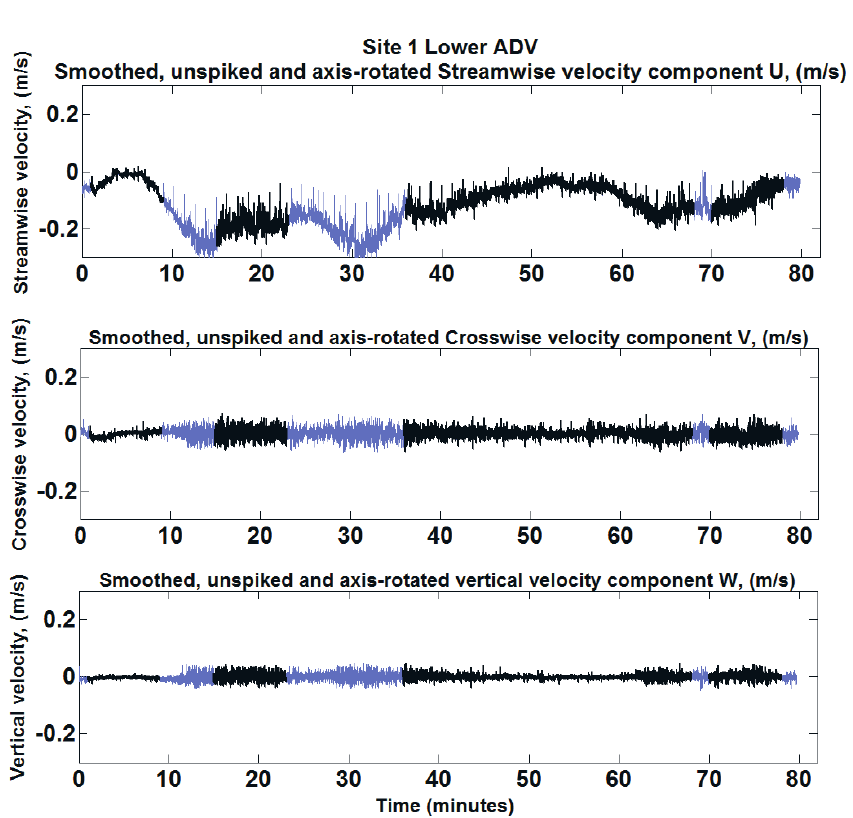
Figure 7. Eight minute sections selected in black for the lower ADV of site 1 (0.32 m above seabed). For each section the mean velocity (cid:1847)(cid:3365) , the turbulence U*, and the standard deviation (of (cid:1847)(cid:3365) and U*) are